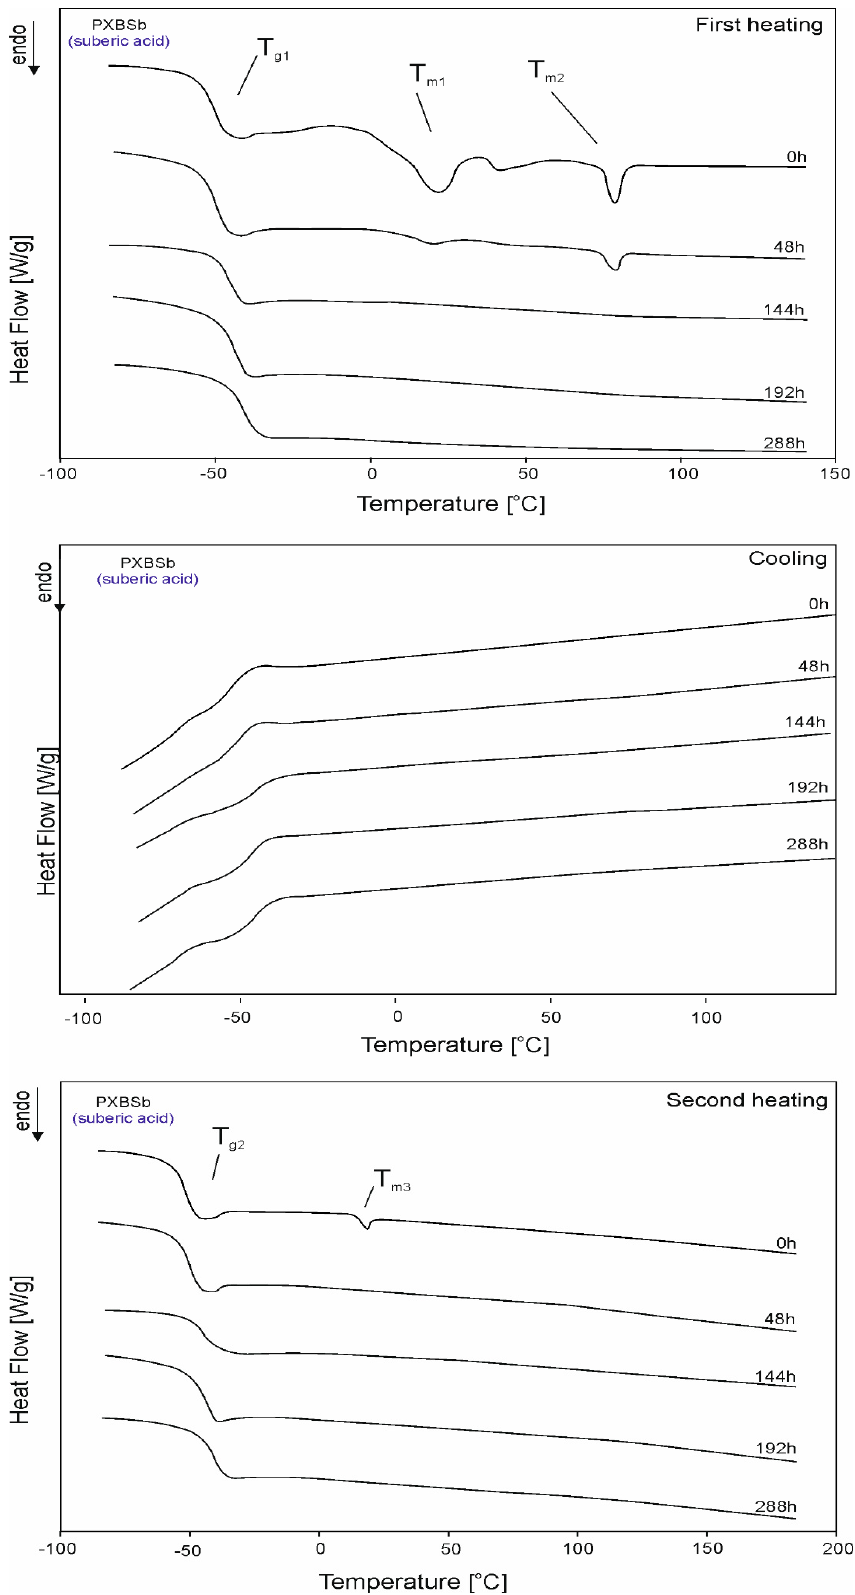
Figure 6. DSC thermograms of PXBA at the crosslinking stages subjected to first heating, second heating and cooling.